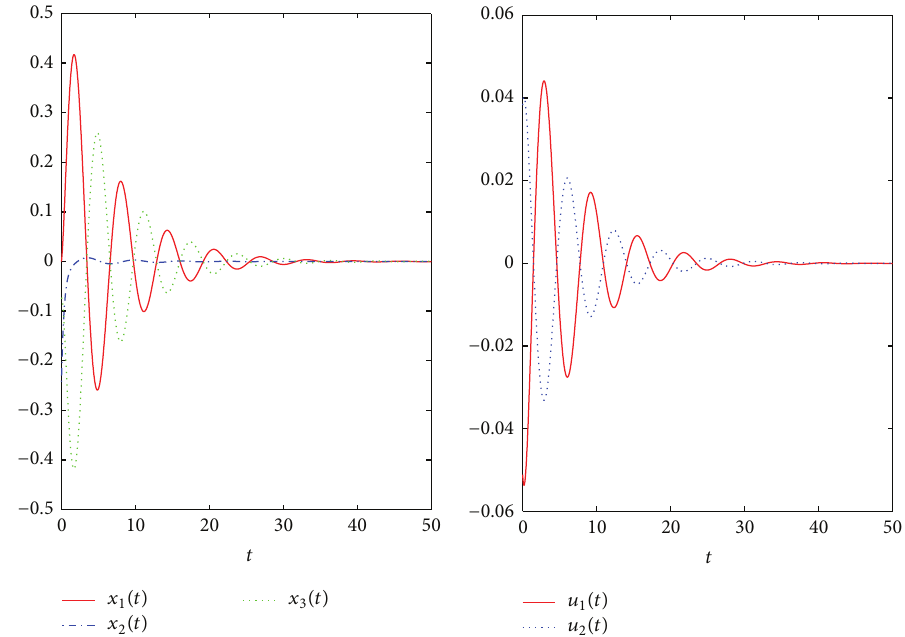
Figure 1: Curves of the state and control variables when exosystem is asymptotically stable.